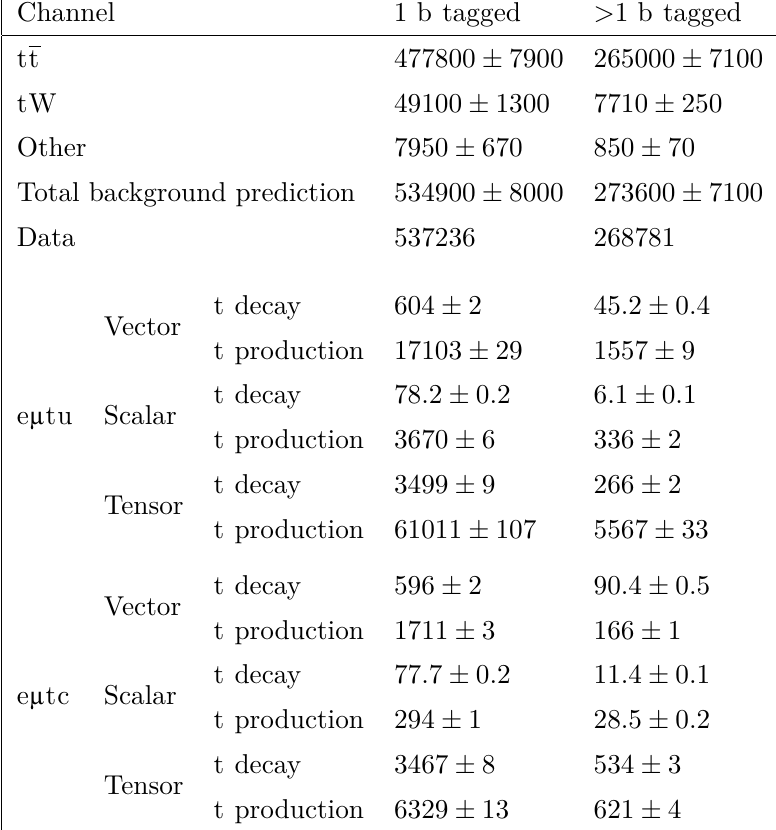
Table 2 . The number of expected events from SM tt , tW , and from the other backgrounds; and the total background expectation and the number of events observed in data collected during 2016–2018, after all selections in signal (1 b tagged) and control ( > 1 b tagged) regions. The total uncertainty, including both statistical and unfited systematic components, is quoted in quadrature for the expected backgrounds. The expected signal yields for single top quark production and top quark decays via the vector, scalar, and tensor CLFV interactions are also shown with their MC statistical uncertainties, assuming C / Λ 2 = 1 TeV − 2 x